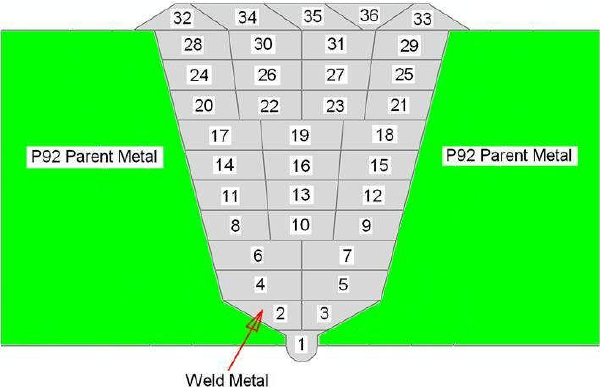
Figure 3. Sketch of weld bead sequence showing overall weld dimensions. Figure 4. Weld pass sequence in the FE model. Table 1. Chemical composition of the pipe and weld materials.